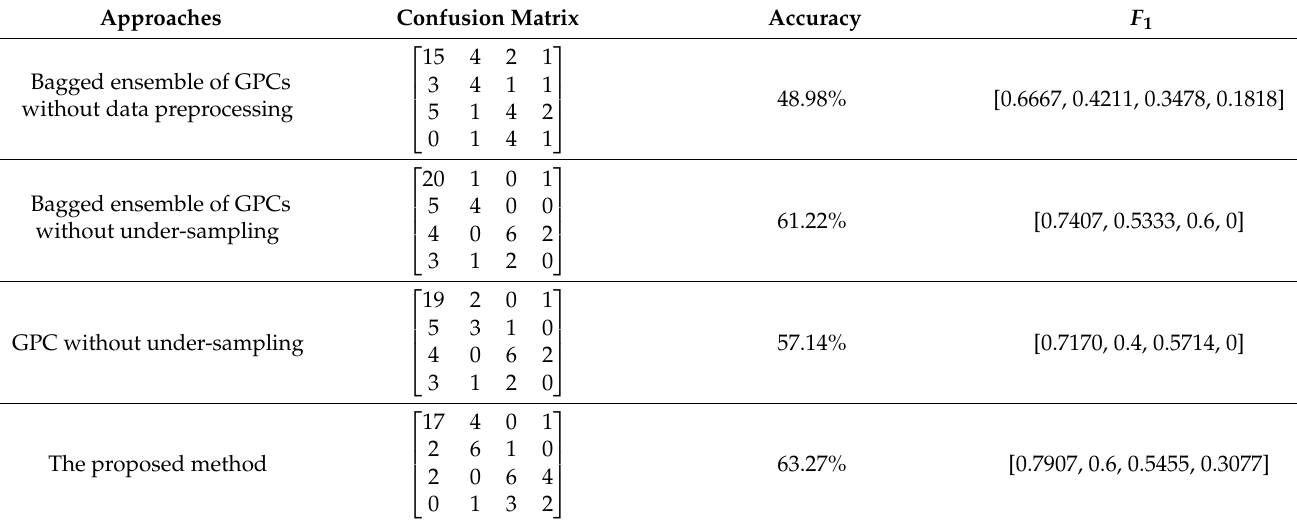
Table 3. Evaluation results of different